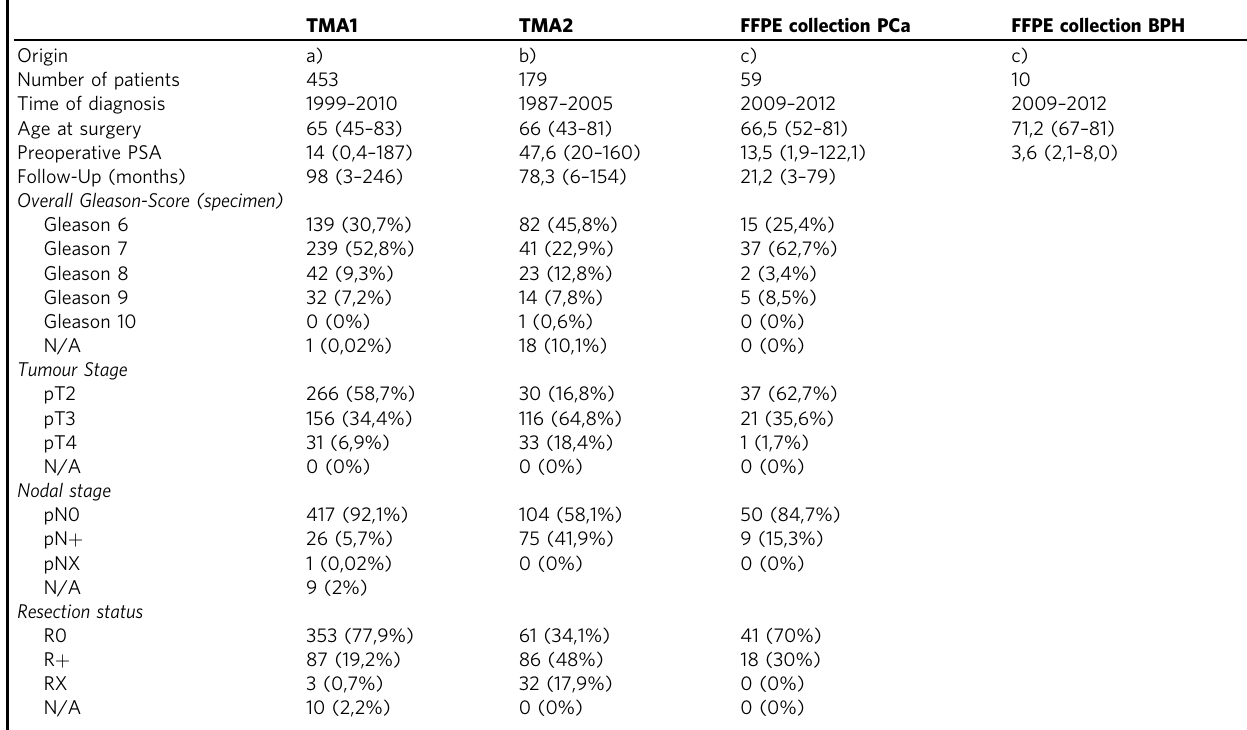
Table 1 Clinical characteristics of PCa patient cohorts used in the